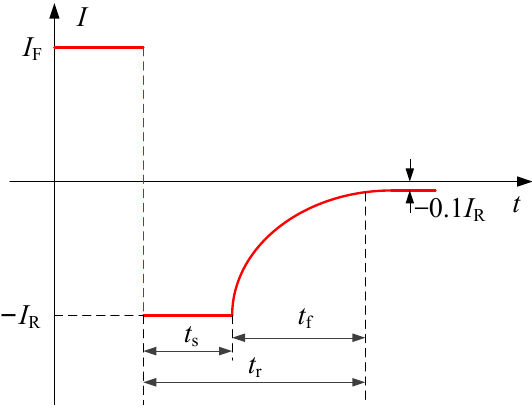
Figure 1. Diode reverse recovery process.